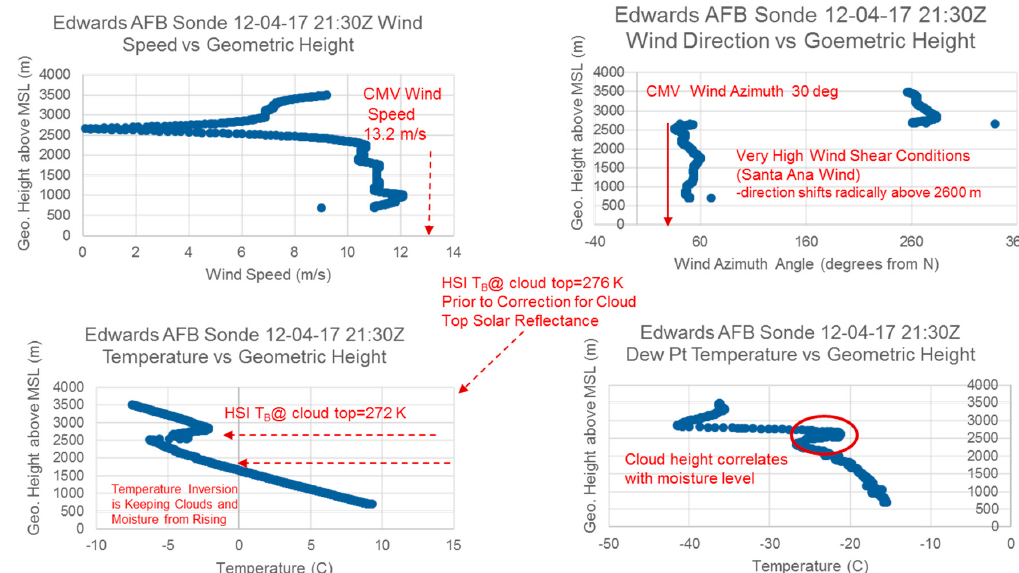
Figure 12. 4 December 2017 21:30Z radiosonde observation over Edwards AFB and related MISTiC airborne observations for cloud motion vector winds. The radiosonde observations and MISTiC observations provide a consistent and physically sensible picture of the local thermodynamic and wind environment.